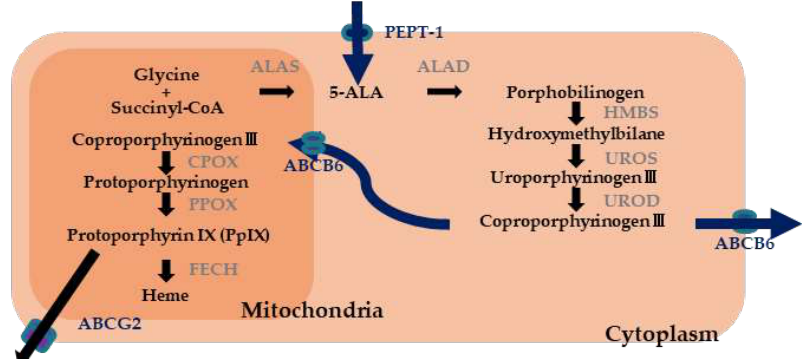
Figure 4. Hemo biosynthetic pathway.